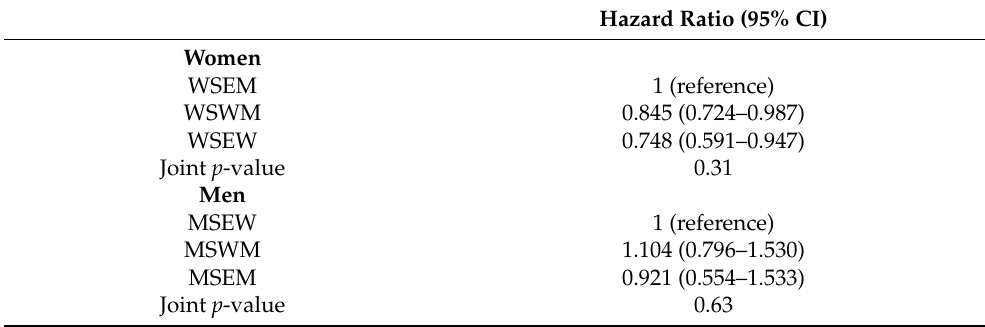
Table A2. Model of lung cancer incidence in women and men. Adjusted only for age and